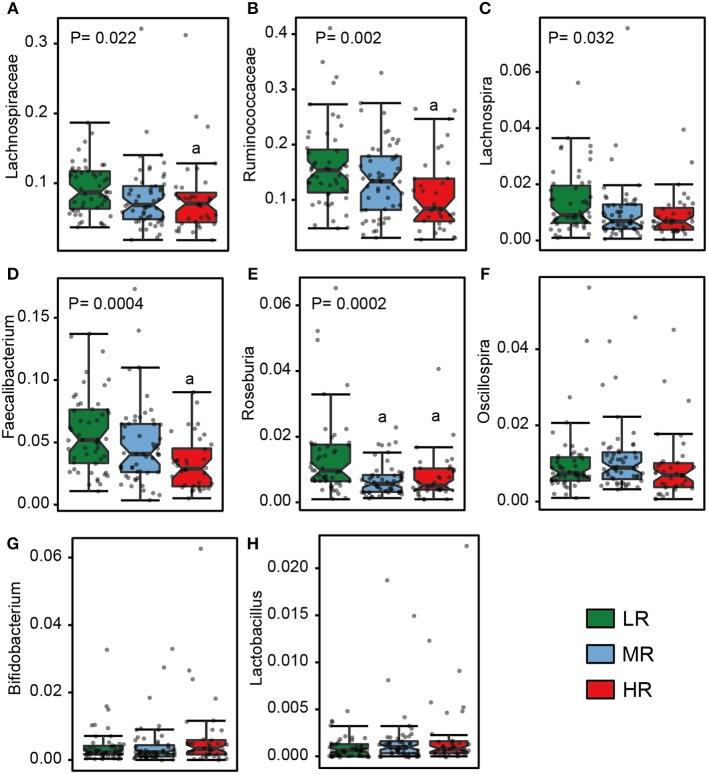
The relative abundance of butyrate- (A–F) and lactate-producing bacteria (G–H) in the gut in the LR (n = 51, green), MR (n = 54, blue), and HR groups (n = 36, red). The significances (P-value) among three groups were determined by the Kruskal–Wallis test and subsequent pairwise comparisons were adjusted by Bonferroni correction. “a” denotes instances where p < 0.05 when a comparison was performed with the LR group. LR, low-risk group; MR, medium-risk group; HR, high-risk group.